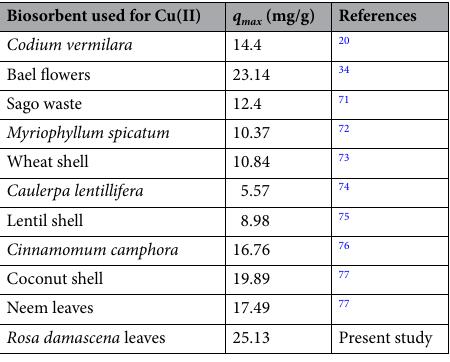
Table 7. Maximum biosorption capacity of Cu 2+ ion by low-cost